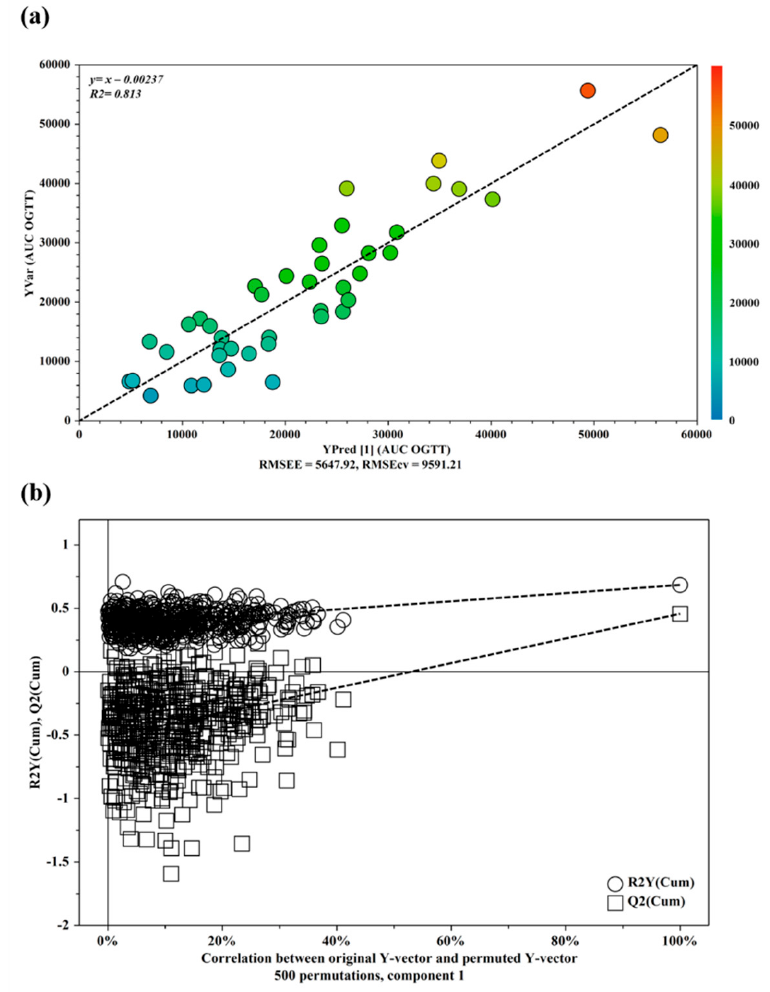
Figure 2. ( a ) OPLS plot showing the relationship between the metabolic profile and the AUC OGTT values. The horizontal axis represents the observed values, and the vertical axis represents the predicted values. ( b ) Validation plots of OPLS model using a permutation test. The horizontal axis shows the correlation between the permuted and actual data, while the vertical axis displays the cumulative values of R 2 and Q 2 . The intercept gives an estimate of the overfitting phenomenon. Table 4. ( a ) Statistical differences of metabolites characterized by VIP > 1. ( b ) Statistical parameters of the receiving operator characteristic (ROC) curves of the metabolites with p -value <